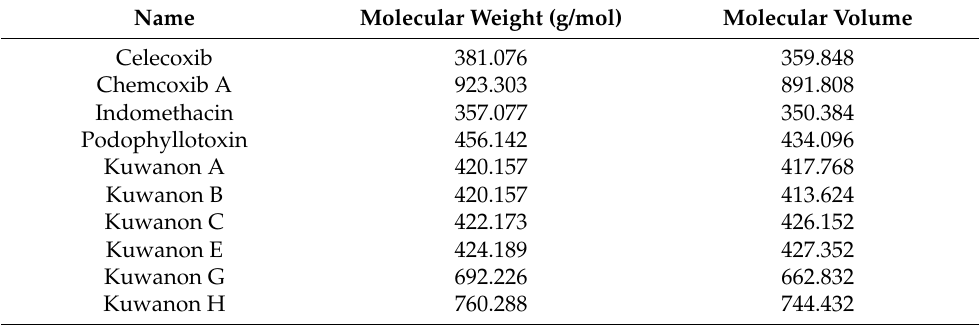
Table 2. Molecular weight and volume for COX-2-bound drug, components of chemocoxib A (indomethacin and podophyllotoxin), and kuwanon derivatives.